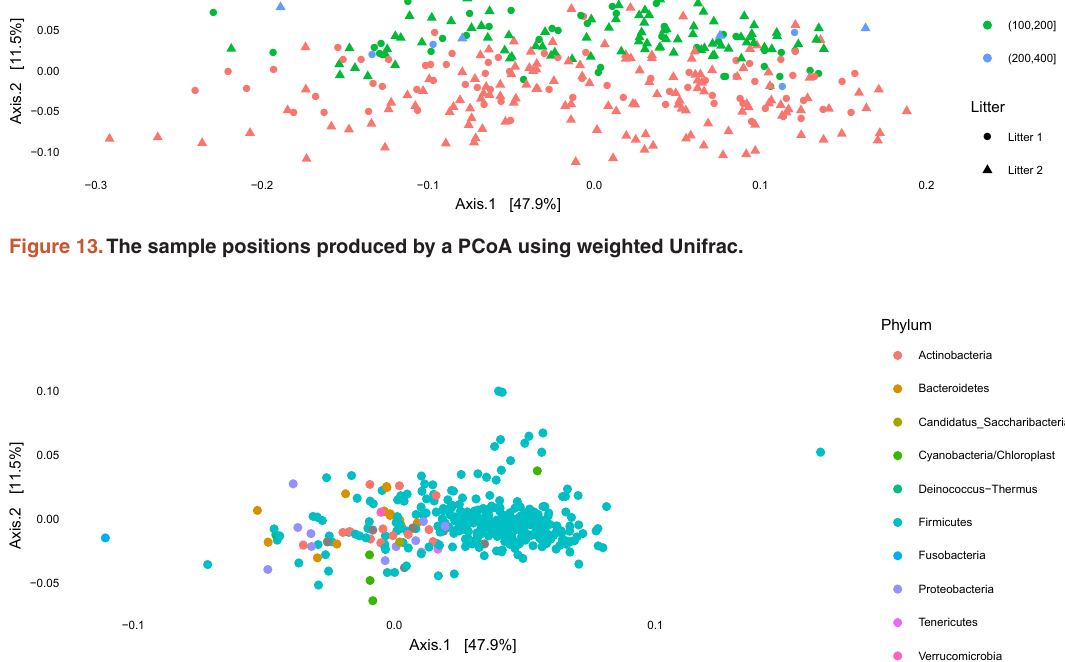
Firmicutes Fusobacteria Proteobacteria (cid:55)enericutes